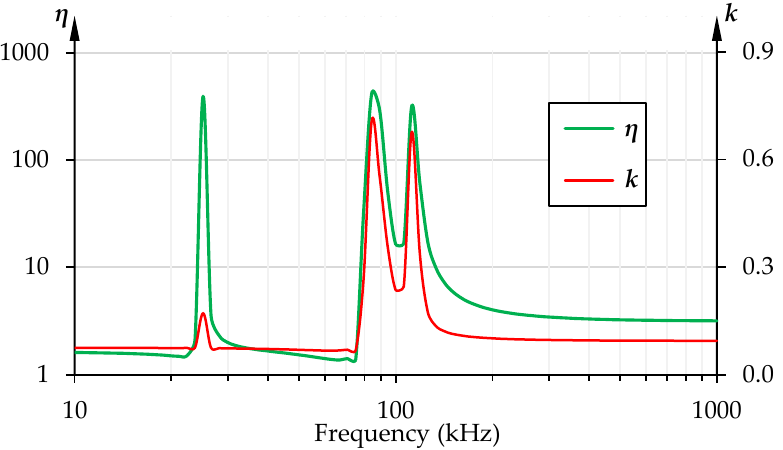
Figure 11. Frequency response of the magnetic meta-hose with the highest energy transfer gain η ( ν = 0.15, µ m = 150) identified at f r = 25 kHz.